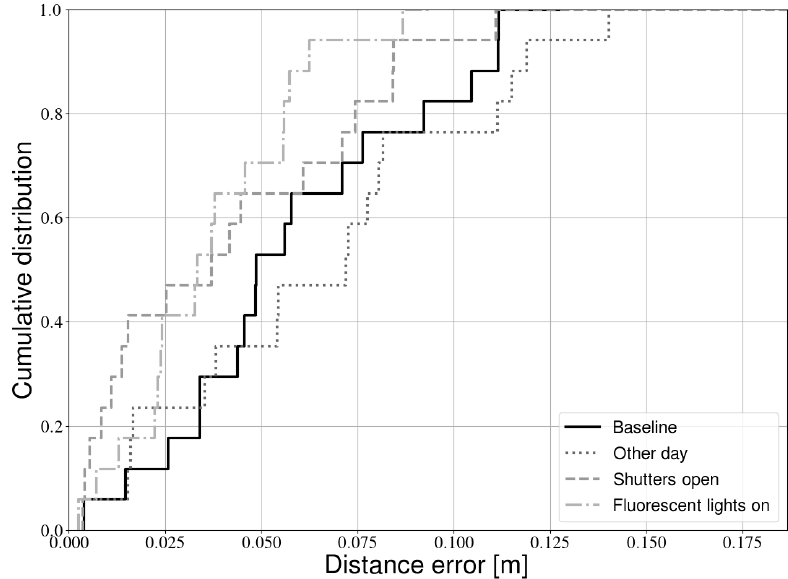
Figure 9. Influence of environmental conditions on calibration